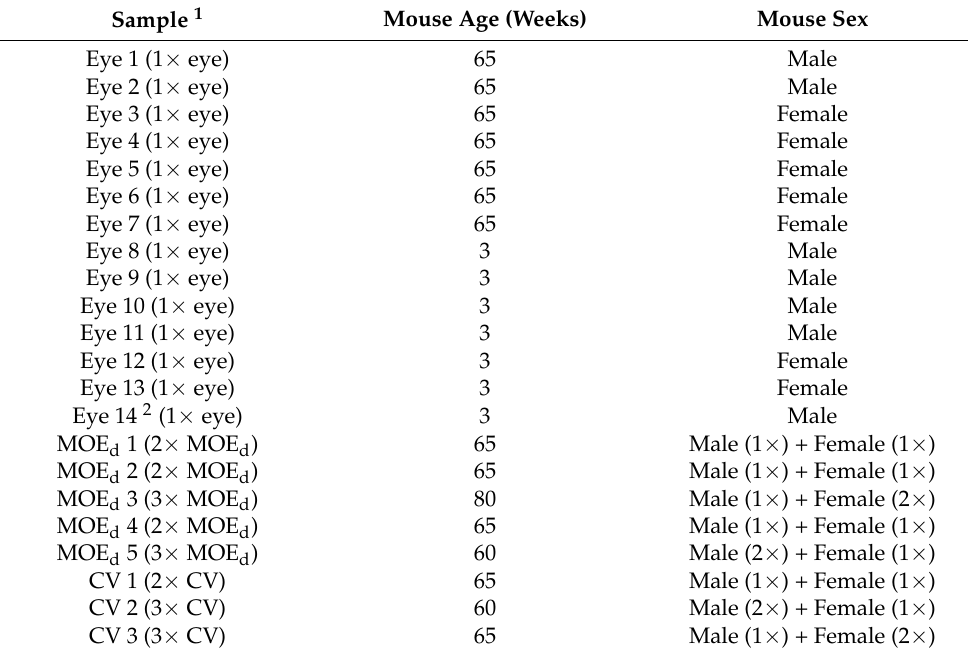
Table 1. Sample characteristics used in RT-PCR and RT-qPCR